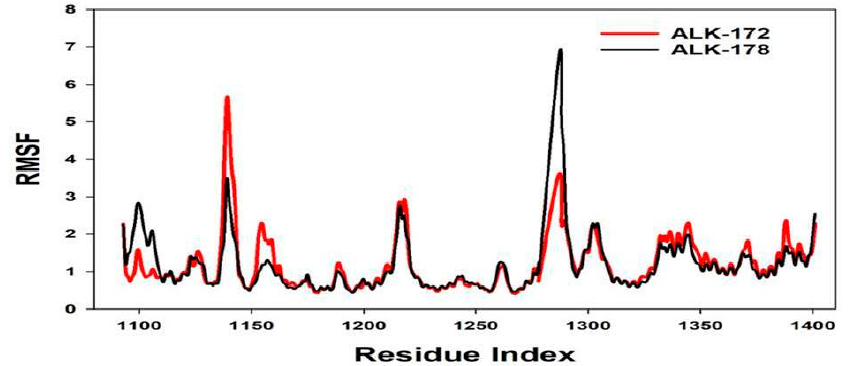
Figure 14. MD simulation trajectory analysis of Root Mean Square Fluctuations (RMSF) of 172 and 178 bound with ALK at 100 ns time frame displayed H-Bond plot of 172 bound ALK (red), 178 bound ALK (black).